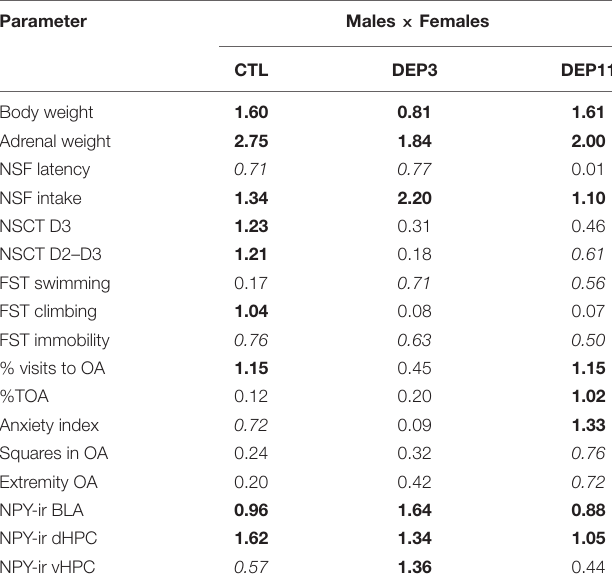
TABLE 5 | Calculation of Cohen’s d effect size between sexes, in each group, for all